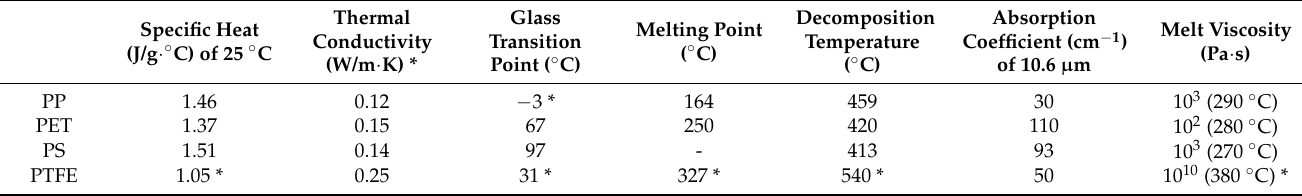
Table 1. Thermal and optical property values of the polymers.